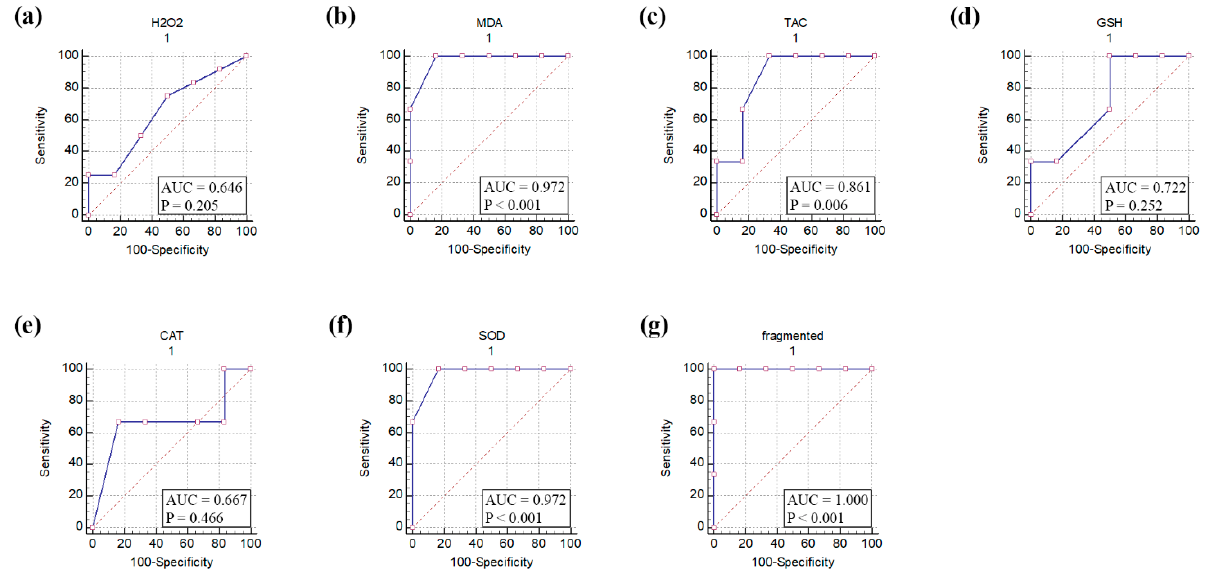
Figure 3. Receiver operating characteristic (ROC) curve of oxidative stress biomarkers, antioxidant biomarkers, and fragmentation of in vitro-aged mouse oocytes. ( a ) Hydrogen peroxide (H 2 O 2 ), ( b ) Malondialdehyde (MDA), ( c ) Total antioxidant capacity (TAC), ( d ) Reduced glutathione (GSH), ( e ) Catalase (CAT), ( f ) Superoxide dismutase (SOD), and ( g ) fragmented oocytes. AUC, area under the curve. p values < 0.05 indicate significance.